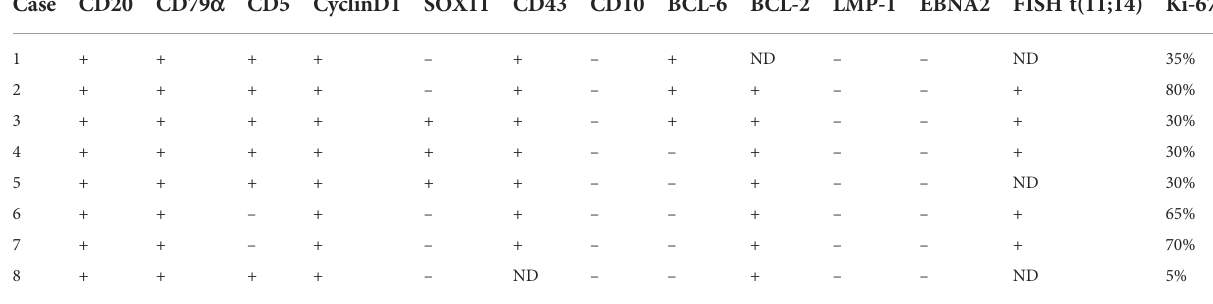
TABLE 4 Immunophenotype and molecular phenotype of MCL with EBER positivity.